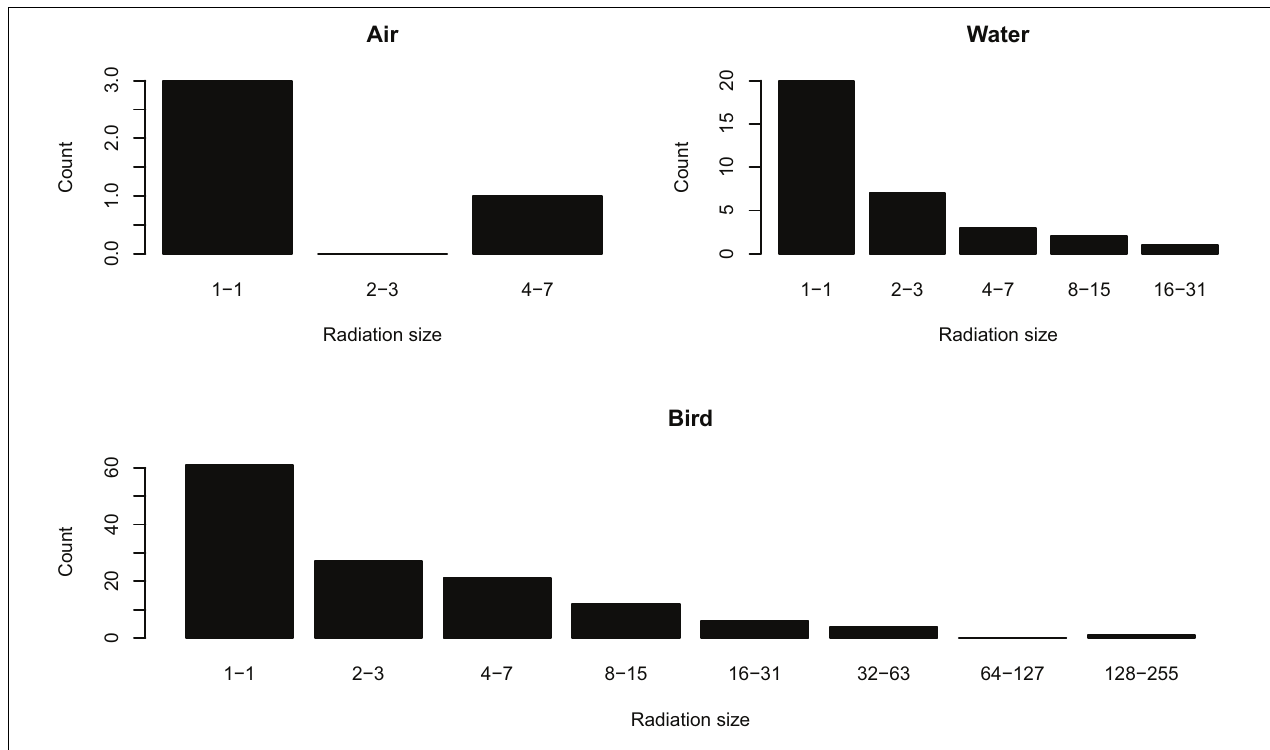
FIGURE 1 | Radiation sizes of Hawaiian angiosperm lineages, separated by dispersal vector. The data are from Price and Wagner (2018). Lineages dispersed by air never reached radiation sizes beyond the 4–7 category. Those dispersing over water were able to reach radiation sizes in the 16–32 category. All the lineages with the greatest radiation sizes of 32 or more were dispersed by